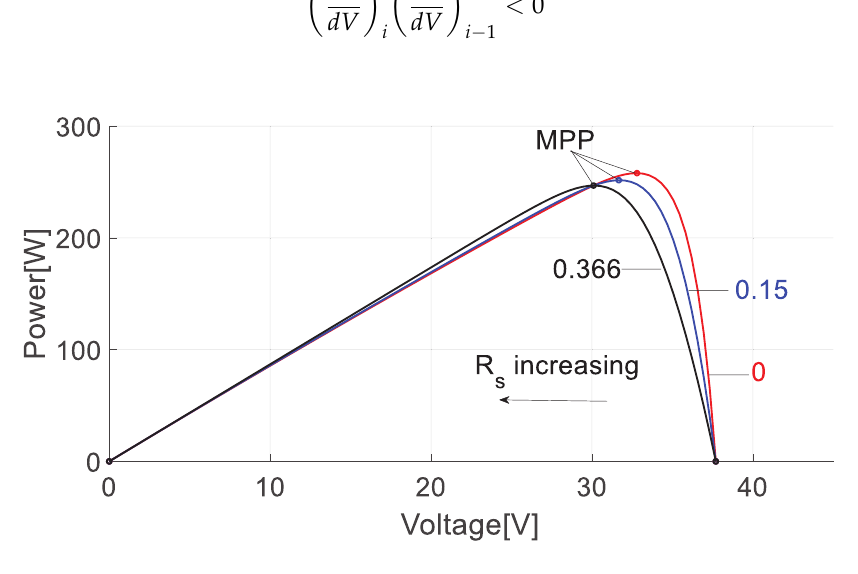
Figure 2. P-V curves plotted for different values of R s